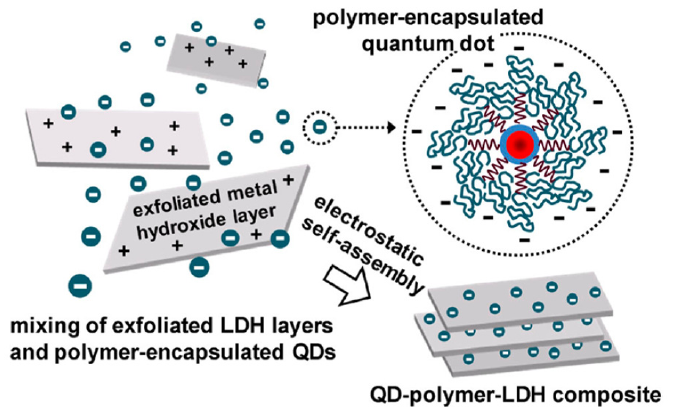
Figure 8. Schematic illustration of the assembly process for the formation of quantum dot (QD)-polymer-LDH composites. Reprinted with permission from Cho et al. [82]. American Chemical Society